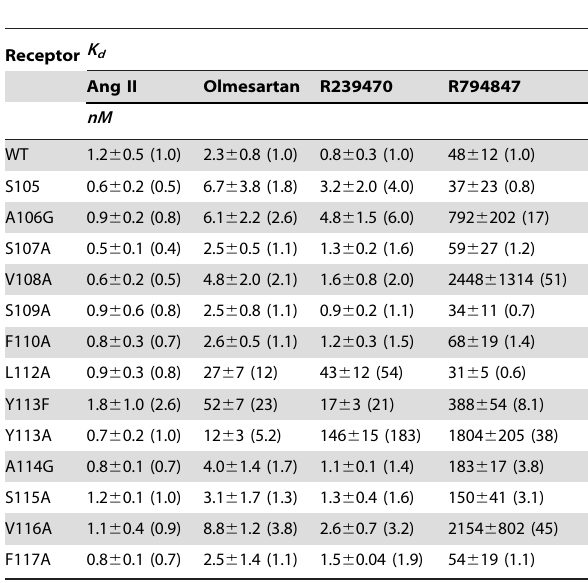
Table 2. Binding affinities ( K d ) of Ang II, olmesartan, R239470 and R794847 to AT 1 wild-type (WT) and mutant